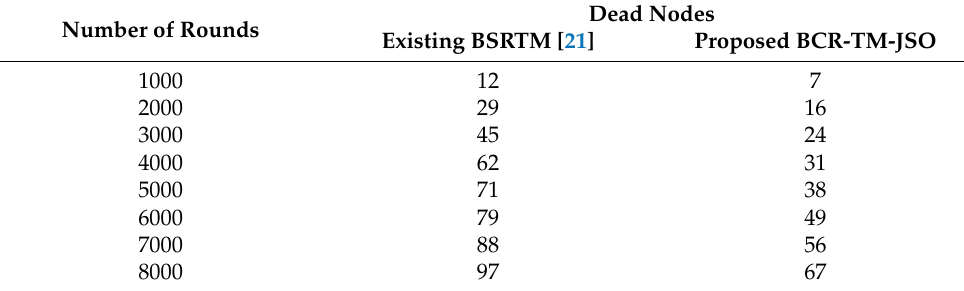
Table 5. Performances of network lifetime in terms of dead